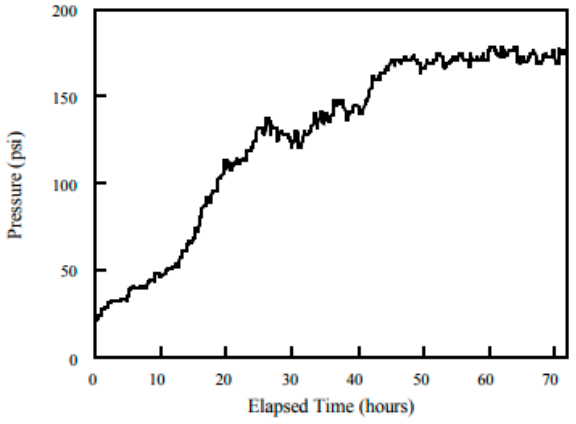
Figure 2. Fouling of San Tomé test loop with Zuata crude oil. Venezuela. [1].